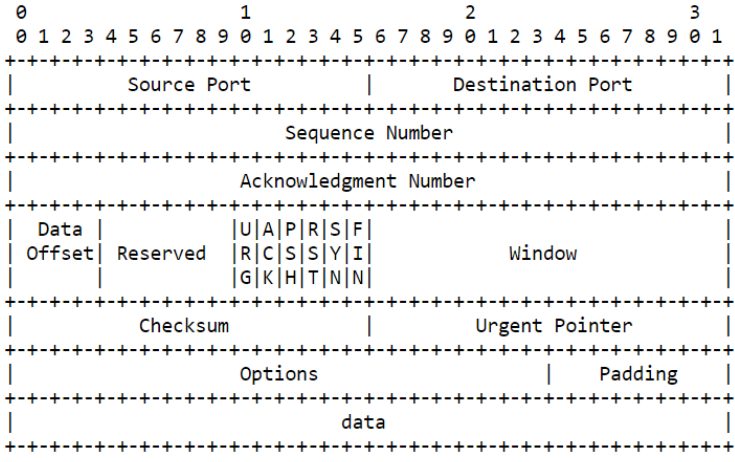
Figure 3. TCP header format (reference source: RFC ‐ 793) [6].